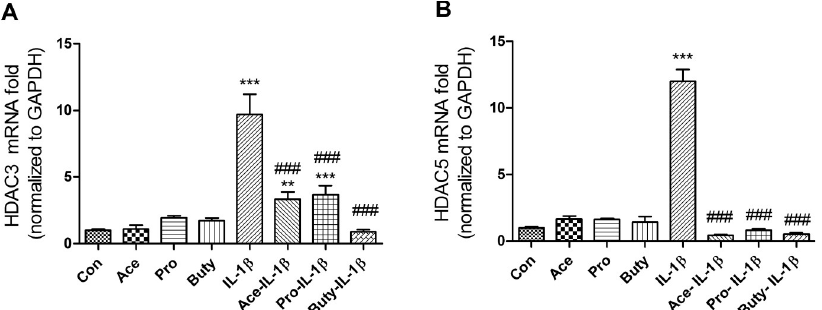
Fig 4. SCFAs inhibit IL-1 β induced histone deacetylases HDAC3 and HDAC5 mRNA expression in immature enterocytes. H4 cells (A-B) were pretreated with 20 mM of SCFAs for 30 min before IL-1 β stimulation (1ng/ml for 4h). HDAC3 (A) and HDAC5 (B) mRNA expression were determined by real time RT-PCR. Data are represented as the mean ± SEM of three independent experiments. One -way ANOVA and Tukey post hoc tests were used for statistic, n = 3. Differences comparison to the control group were considered significant at �� p < 0.01, ��� p < 0.001; differences comparison to the IL-1 β group were considered significant at ### p < 0.001.